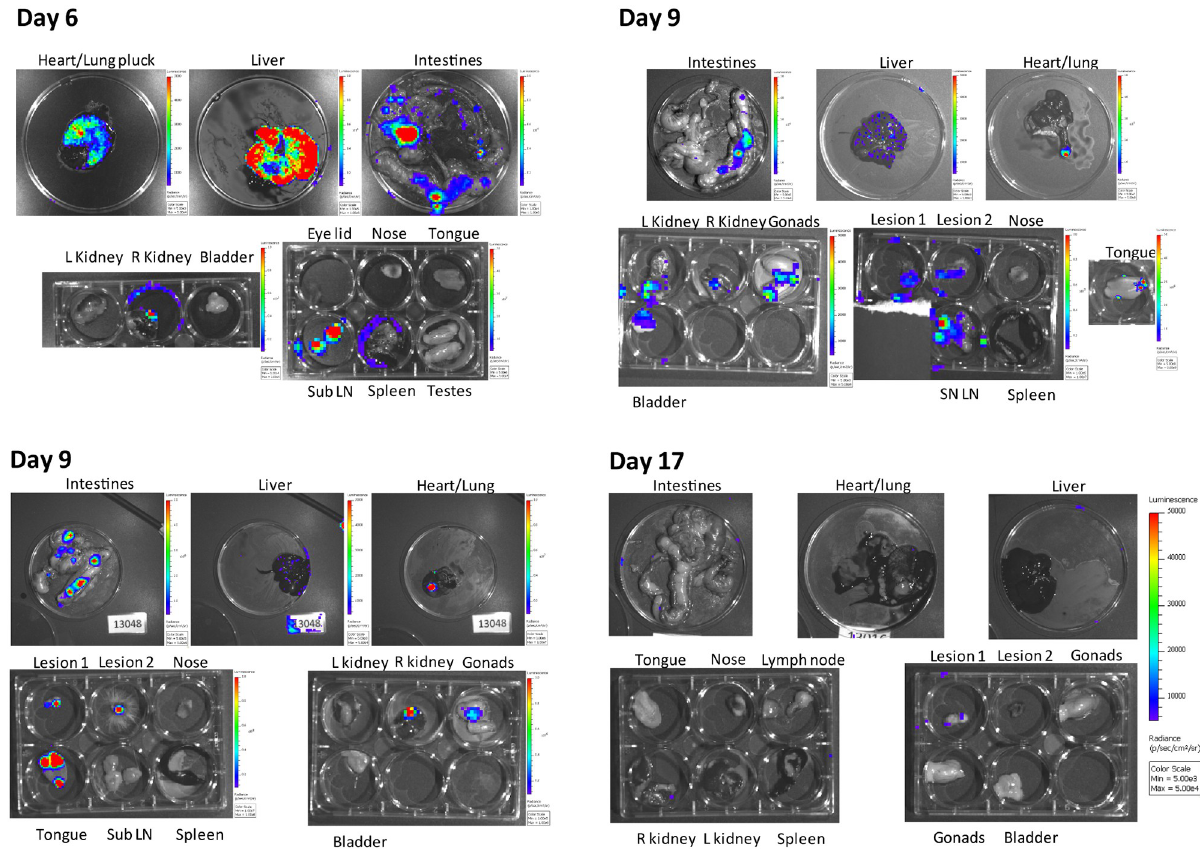
Fig 4. Imaging organs ex vivo reveals sites of internal viral replication. Prairie dogs infected with luc+ MPXV were imaged on indicated days, injected via intracardiac route with additional luciferase and immediately euthanized and necropsied. Organs were removed and imaged for presence of luciferase, representing areas of replicating MPXV. Images are black and white photograph of a representative set of organs from a single prairie dog taken at each time point overlaid with a false color representation of photon emission intensity as indicated by the scale on the right in ps -1 cm -2 sr -1 . In some cases organs that produced especially high levels of luminescence would be covered by black construction paper and re-imaged to visualize other organs that may require longer exposure rates.